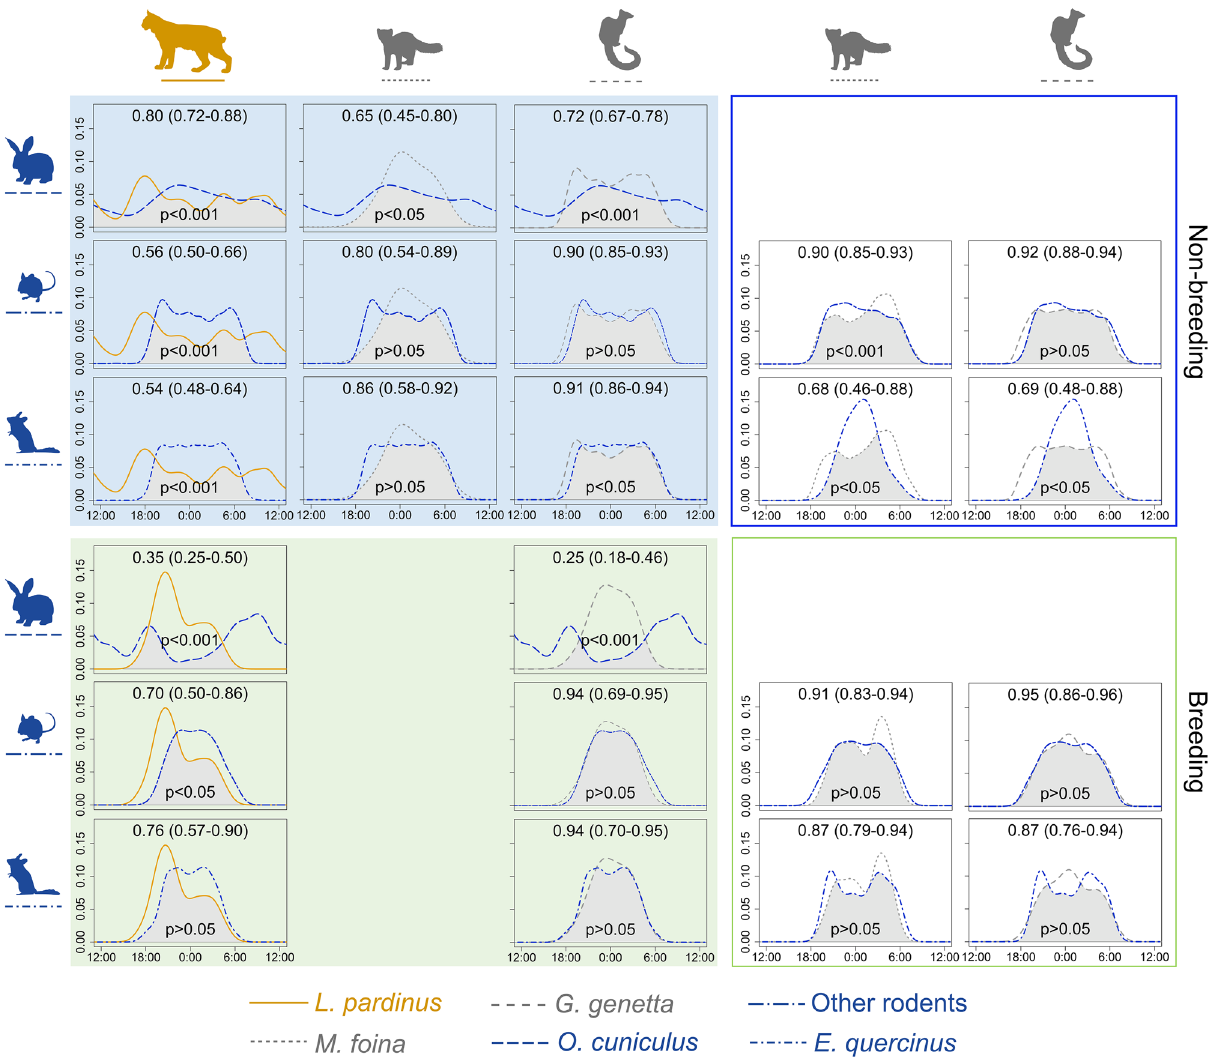
Figure 4. Temporal activity patterns of carnivores and prey species in localities with Iberian lynx presence (colour-filled boxes) and localities without lynx (non-colour filled boxes) outside breeding season (blue) and inside (green). Apex predator is represented by orange, mesocarnivores by grey and prey by blue. Iberian lynx (solid line), common genet (dashed line), stone marten (dotted line), European rabbit (long dash line), other rodents (long dot–dash line) and garden dormouse (dot–dash line). Empty plots refer to overlap unrealized